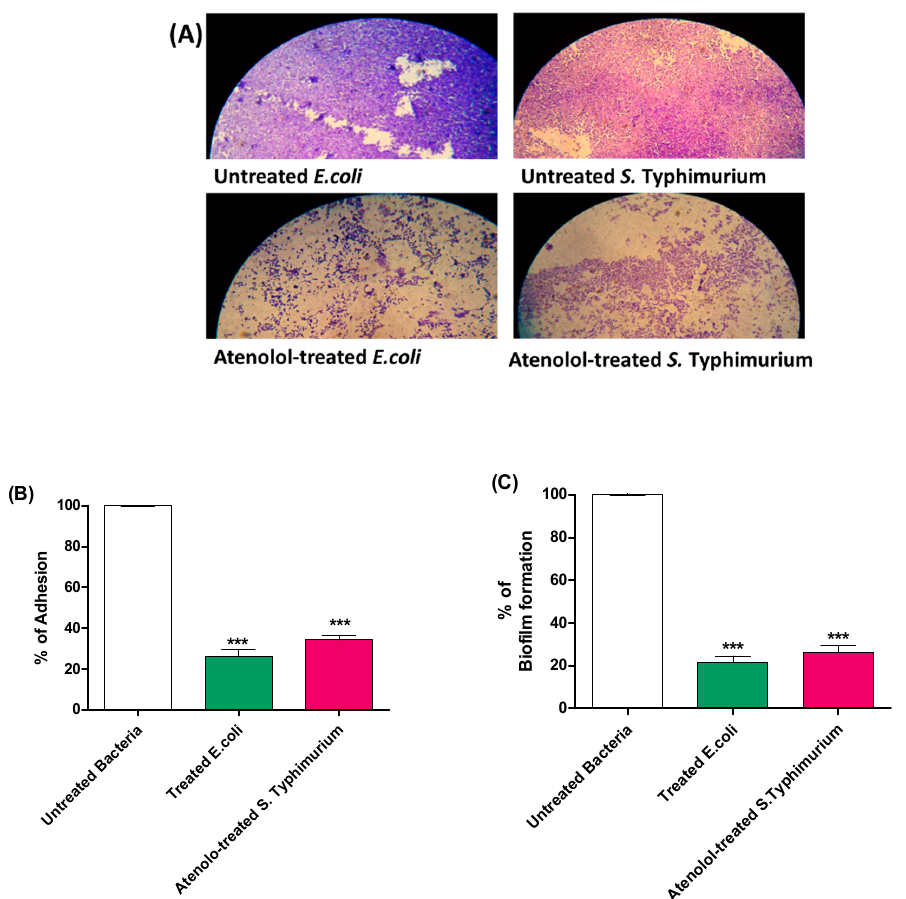
Figure 2. Effect of atenolol at sub-MIC on bacterial adhesion and biofilm. ( A ) Representative light microscope images show the obvious reduction in the S. typhimurium and E. coli K-12 biofilm formation in the presence of atenolol. The absorbances of crystal violet staining ( B ) Adhered cells, and ( C ) Biofilm forming cells in the presence of atenolol compared to untreated control. Atenolol significantly diminished the S. typhimurium and E. coli K-12 adhesion and biofilm formation (*** p < 0.0001). The experiment was performed in triplicate and results are expressed as the means ± standard deviation with p value < 0.05 considered statistically significant.